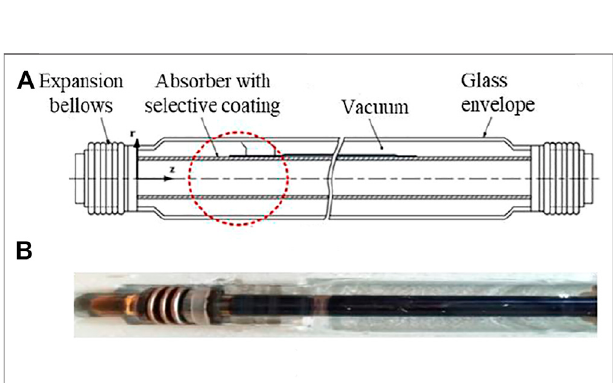
FIGURE 2 | Evacuated tube receiver (A) schematic with internal con fi guration, (B) actual receiver.